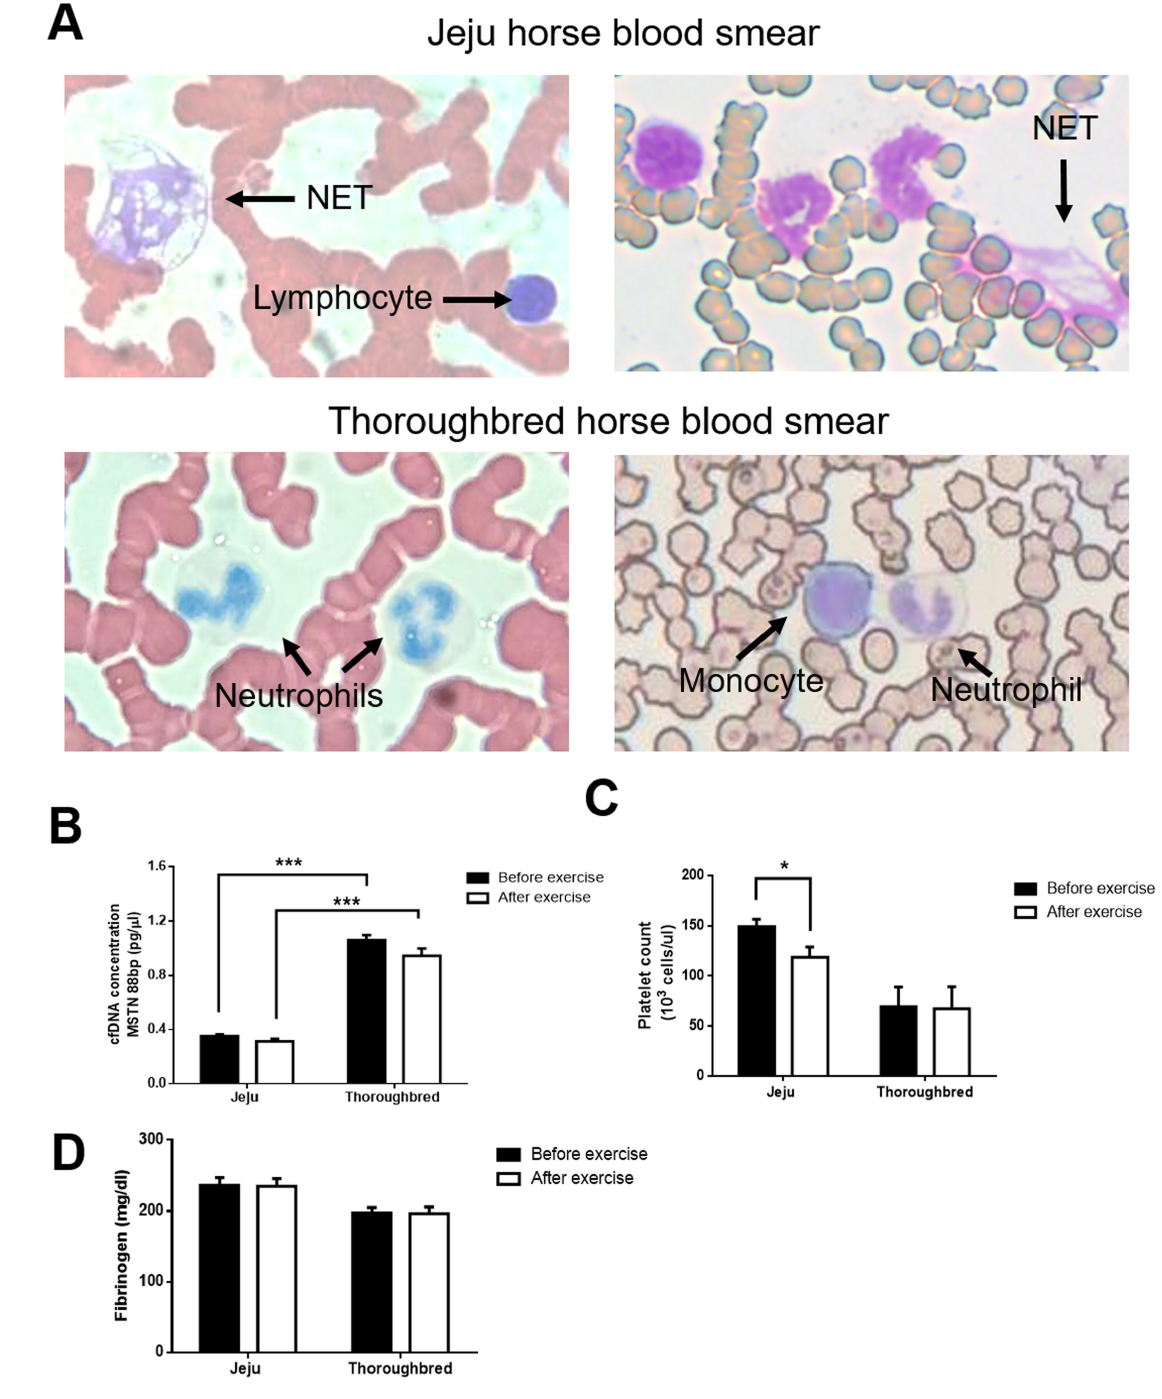
Figure 3. Neutrophil extracellular trap (NET) formation varies between Jeju and Thoroughbred horses, associated with platelet reduction. Jeju and Thoroughbred horses were exercised for 30 min. Blood samples were collected, and plasma was separated. (A) Blood smears from exercised Jeju and Thoroughbred horses were Giemsa stained and observed under a microscope. NETs are indicated using arrows. (B) Plasma cfDNA levels were measured using real-time polymerase chain reaction and specific primers to produce an 88 bp fragment of the chromosomal myostatin MSTN. (C) Platelet count; and (D) fibrinogen levels. Black and white circles represent data from before and after exercise, respectively (n = 5 per breed; * p<0.05, ** p<0.01, and *** p<0.001, unpaired Student’s